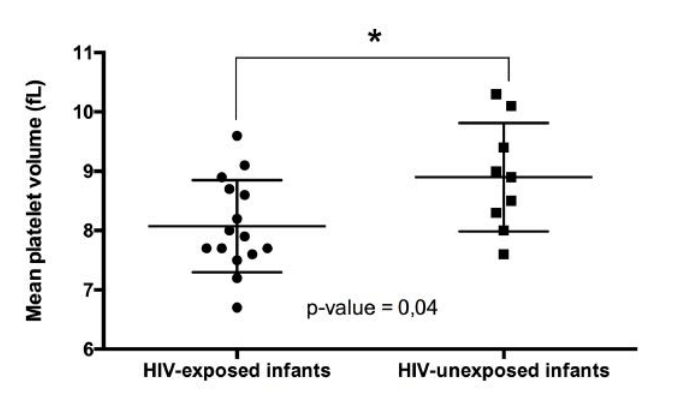
Figure 2. HIV-exposed uninfected (HEU) and HIV unexposed (HU) infants' mean platelet volume: the mean platelet volume (MPV) was significantly lower in HEU infants than HU infants (P=0.04). The observation has no physiological significance as HEU MVPs is within normal range (6-11.1